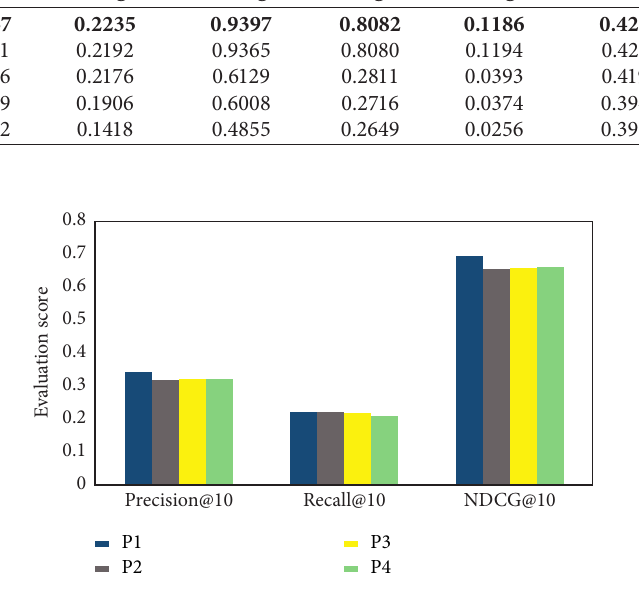
Figure 2: Recommendation performance with different meta-path sets.